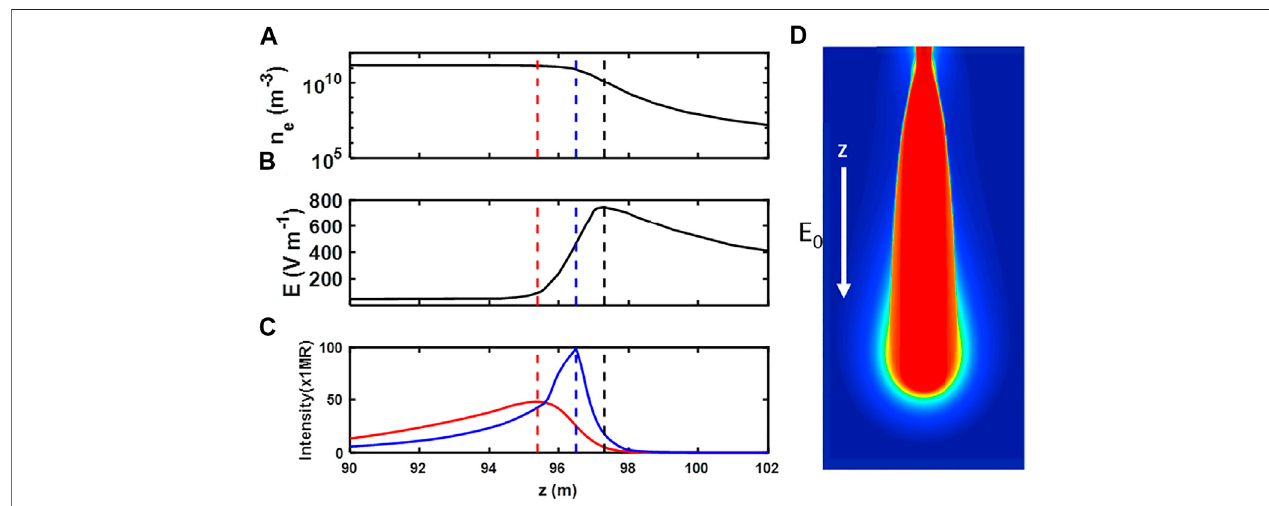
FIGURE 1 | The inhomogeneousspatial distribution ofelectrondensity ( n e ), electric fi eld ( E ), and their 1Pand 2Pemissionintensity ina spritestreamer. Hereweshow thecomputersimulationofaspritestreamerattimeof0.27 mswheretheaxialpro fi lesof (A) electrondensity, (B) electric fi eldand (C) N 2 1Pand2Pintensityareplottedalong thepropagatingdirection( z )withtheambient fi eld12 × N kV cm − 1 ( ∼ 0.4 E k ),and atthealtitude70 km.Theverticalred,blueandblackdashedlinesindicatethepeaksofN 2 N 0 1P,2Pemissionandtheelectric fi eld,respectively.Atimelagbetweentheirpeaksshouldbeconsideredinspriteemissionratios.Panel (D) showthe2Dcrosssectionof the contour plot of positive streamer electron density of a streamer with positive streamer where electric fi eld is downward (Ihaddadene and Celestin, 2017).